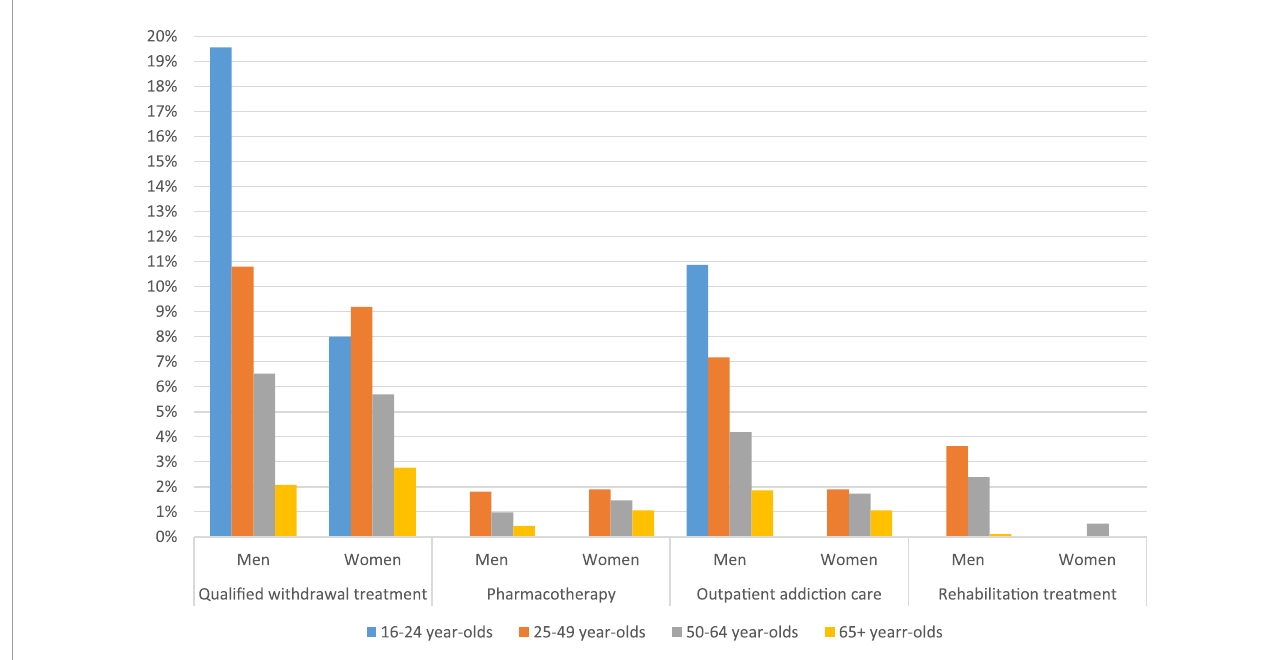
FIGURE3 Specific treatment/care rates of the statutory health insurances’ (SHIs) population with an alcohol dependence syndrome diagnosis (F10.2–4) in 2016/2017, stratified by age and gender. SHIs’ population with F10.2–4 diagnosis in 2016/2017: 16–24-year-olds ( n M = 46; n W = 25); 25–49-year-olds